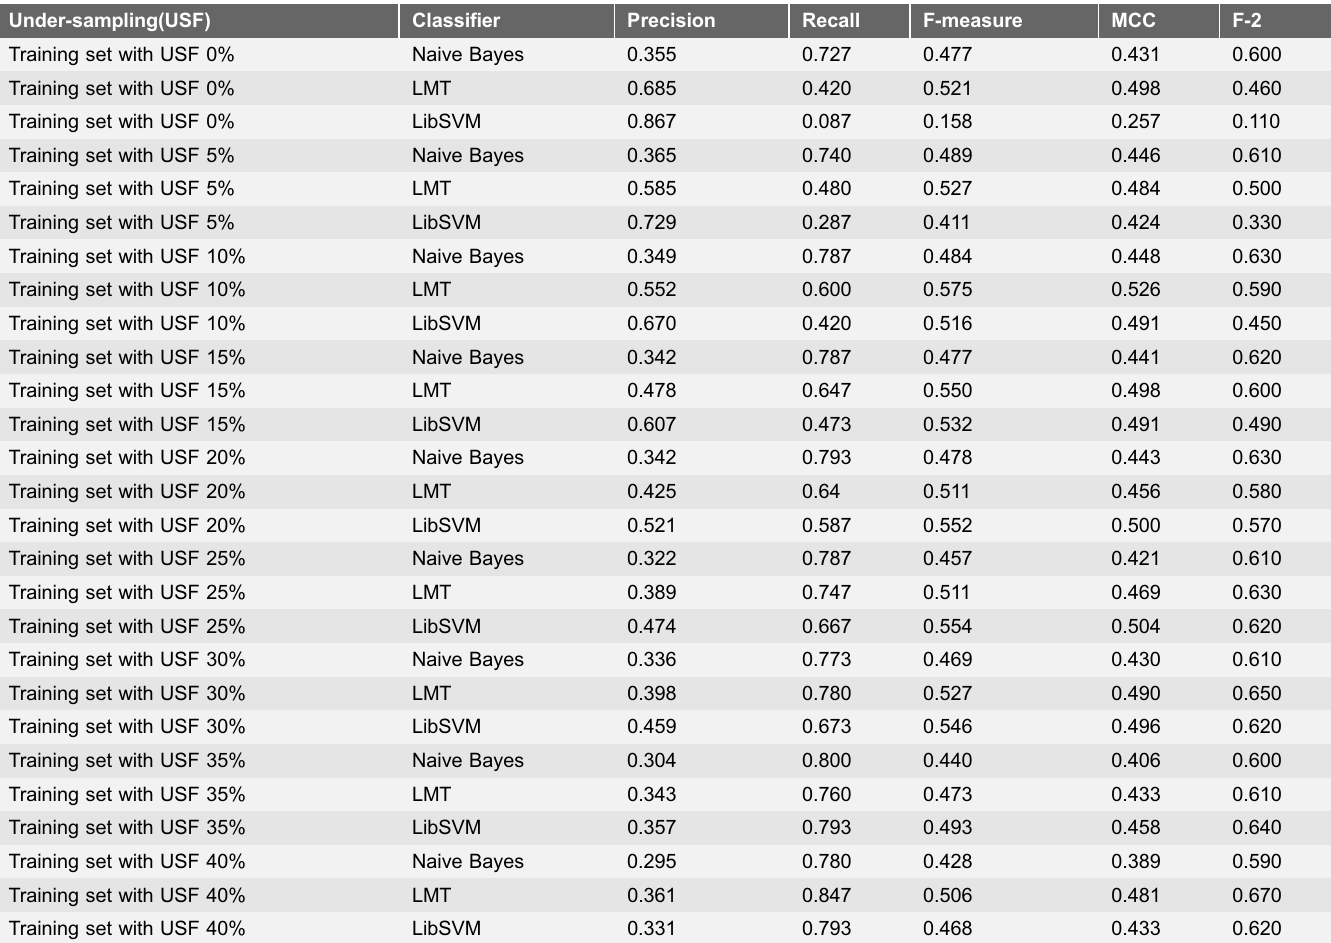
Table 8. mycoSORT Results - Set of Features F1 + F2 + F3 +